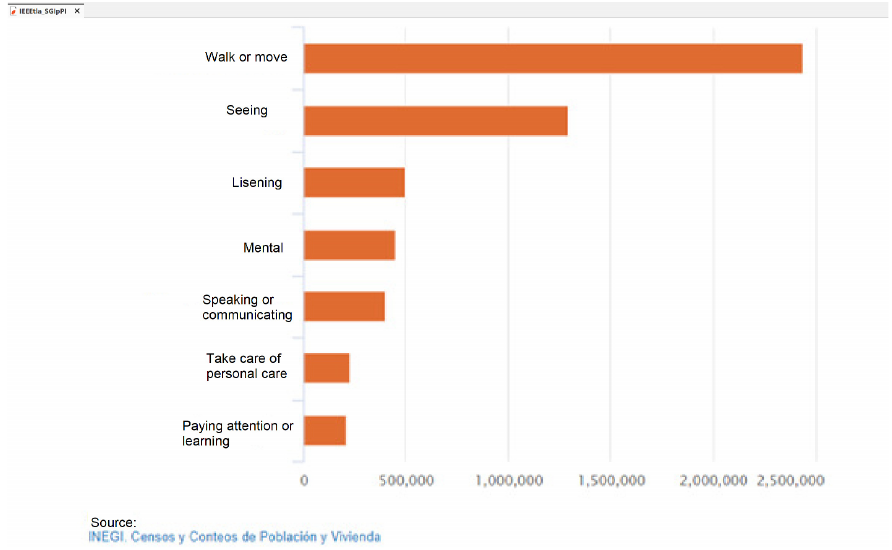
Figure 1. Disability Statistics in